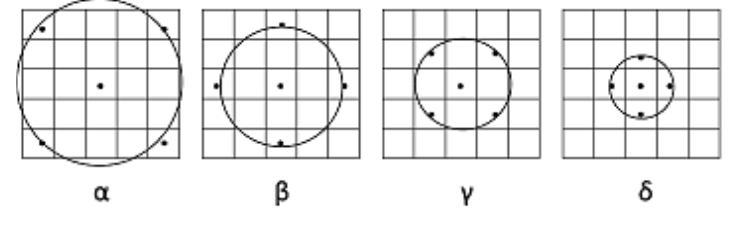
Figure 2: Four Frénicle - Amela-Like